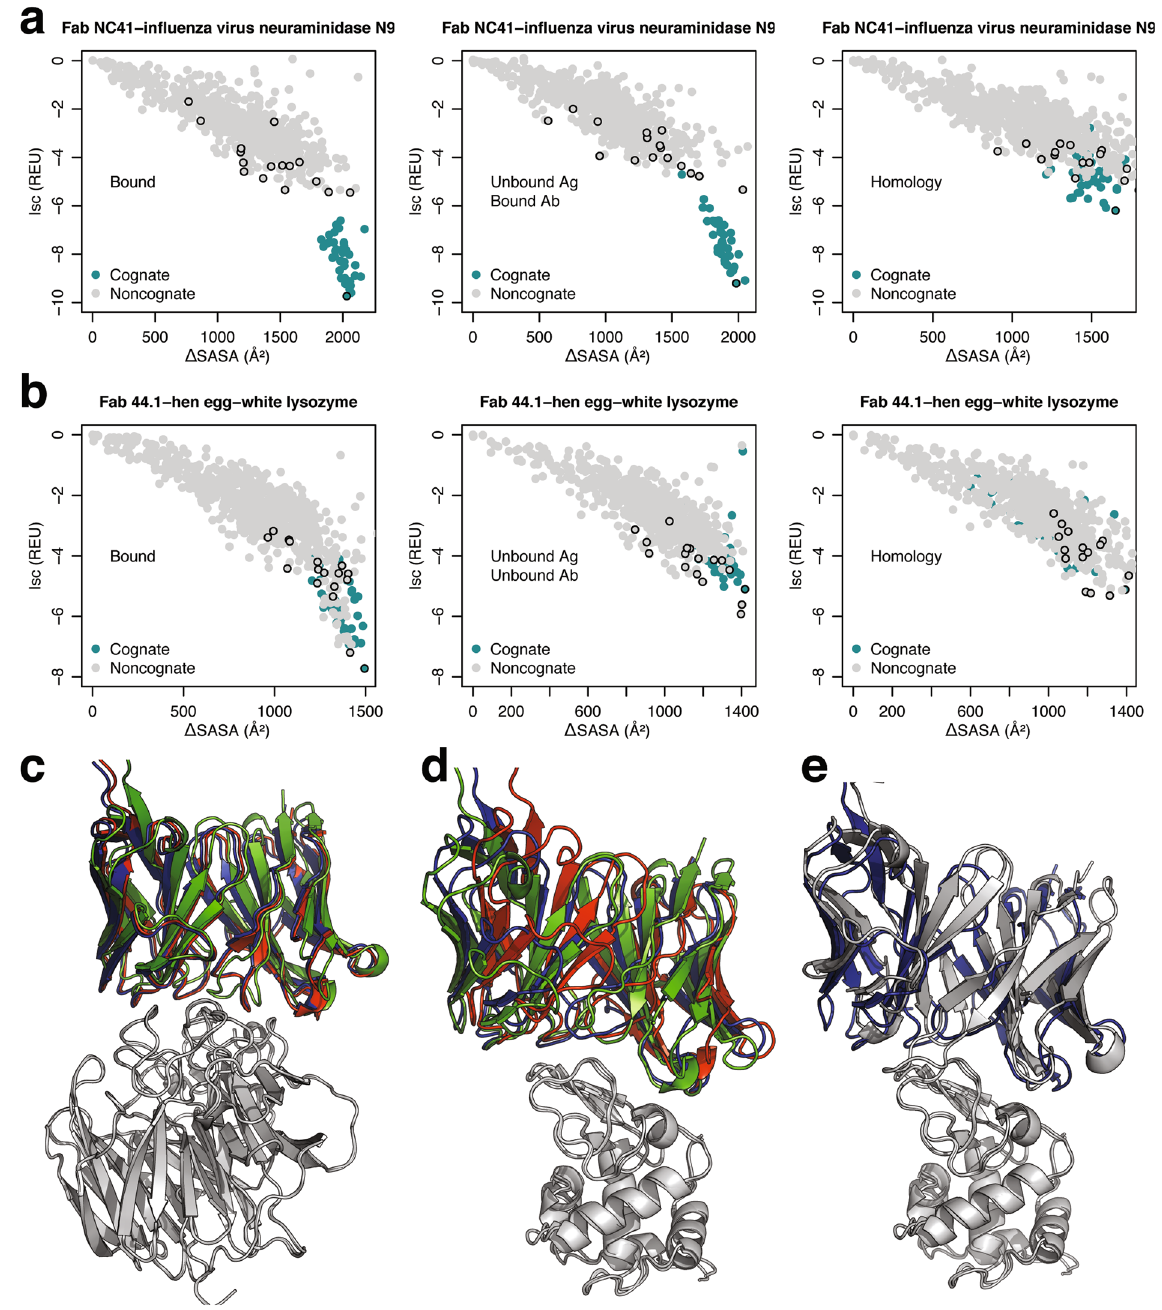
Figure 2. Binding discrimination in Fab NC41–influenza virus neuraminidase N9 and Fab 44.1–hen egg-white lysozyme complexes. Surface area change upon binding ( Δ SASA) vs. Interface scores for model structures in antibody cross-docking tests using bound, unbound, and homology-modeled backbones in ( a ) influenza virus neuraminidase N9, and ( b ) hen egg-white lysozyme. Sixteen non-cognate structures (grey) are compared to cognate structures (turquoise); black outline indicates the top-scoring model for each antibody–antigen pair. The top-scoring cognate complexes generated using bound (red), unbound (blue), and homology (green) complexes in ( c ) influenza virus neuraminidase N9, and ( d ) hen egg-white lysozyme complexes. ( e ) Top-scoring cognate (blue) and non-cognate (grey) antibody against hen egg-white